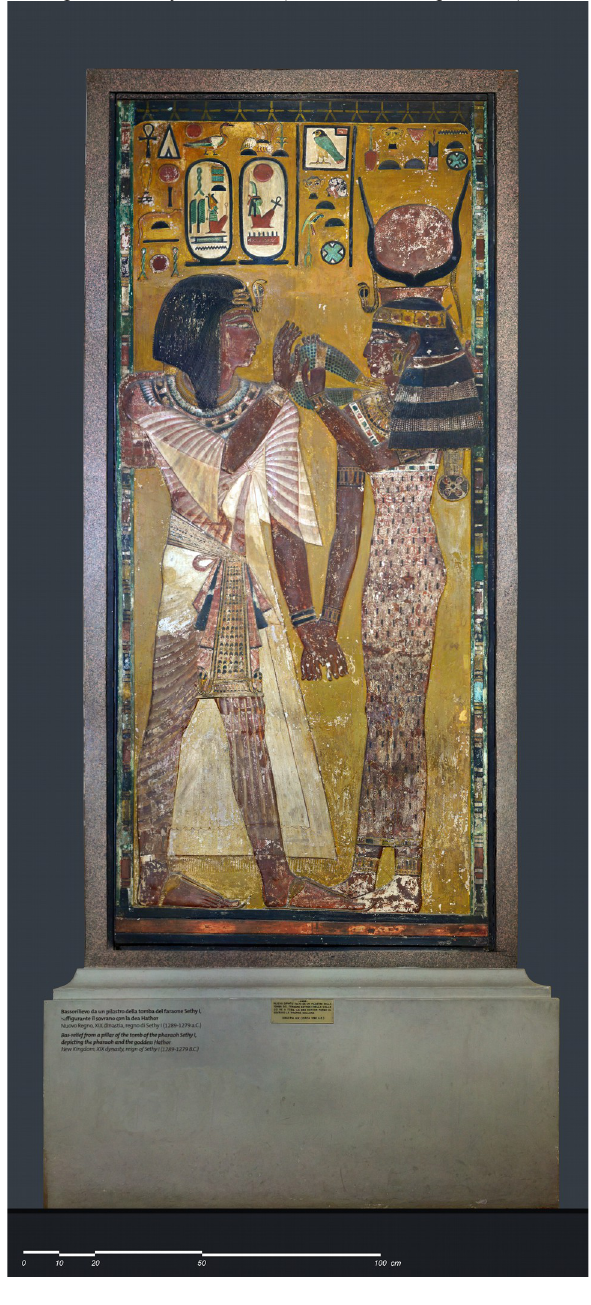
Figure 3. The drawing taken from Ricci, before the cutting and published by Rosellini. (Rosellini, 1834, pl. LVIII).